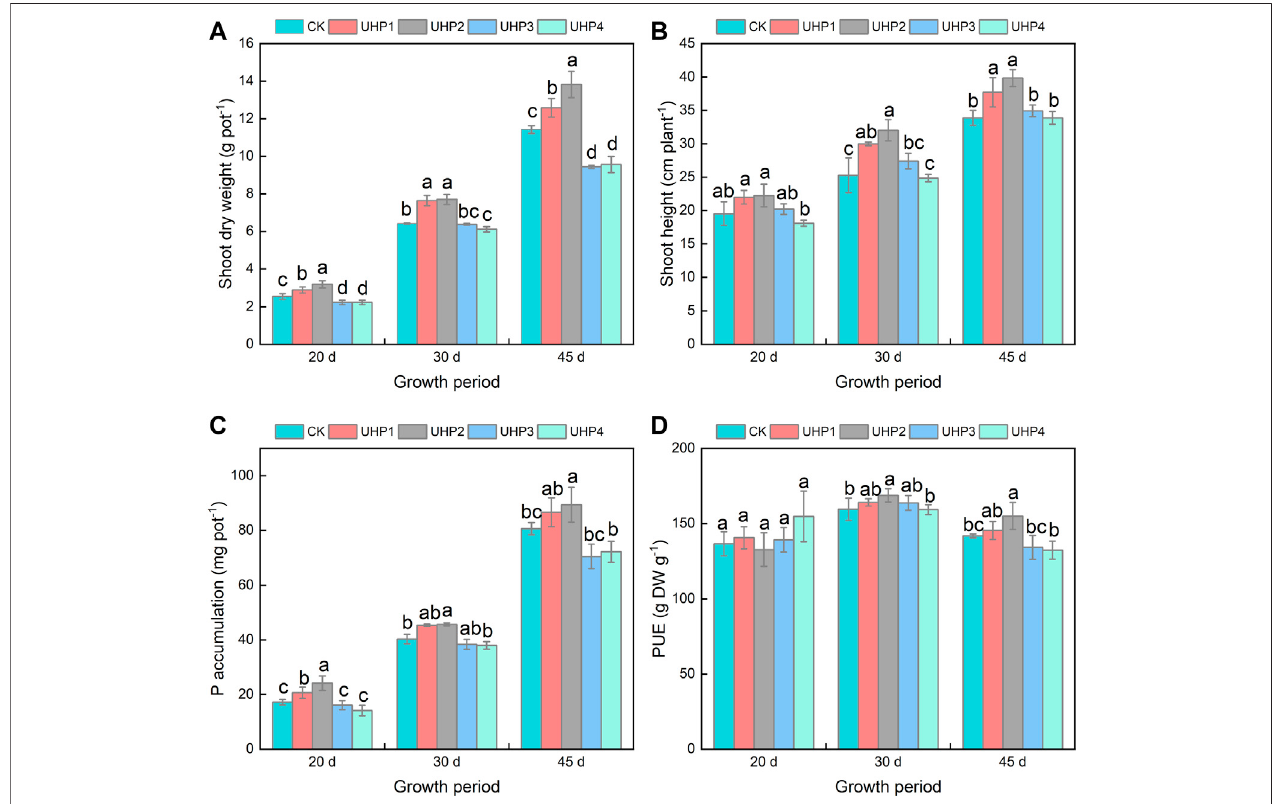
FIGURE 2 | Effects of aeration on the growth, absorption, and utilization of P in amaranth at different growth stages. (A) Shoot dry weight, (B) shoot height, (C) P accumulation,and (D) phosphorususeef fi ciency(PUE).Barsindicatemean±SD.Differentlettersonthebarsindicateasigni fi cantdifference( p < 0.05)betweendifferent treatments in the same growth period.